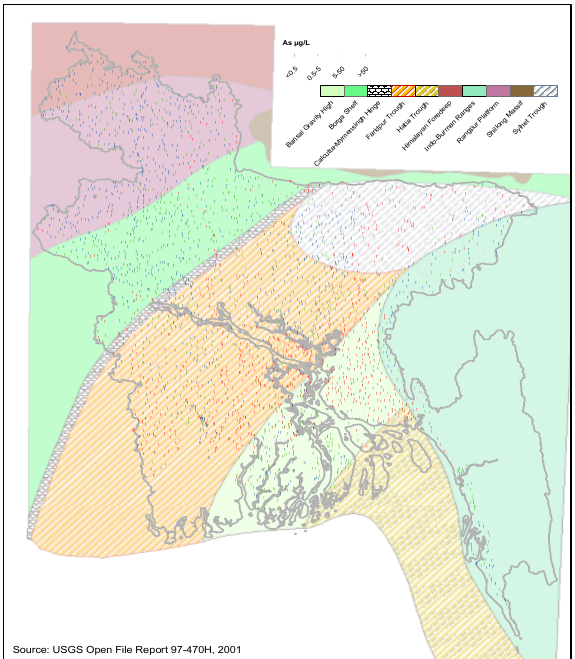
Figure 3: Map showing the distribution of arsenic in the context of the generalized tectonic map of Bangladesh [7,